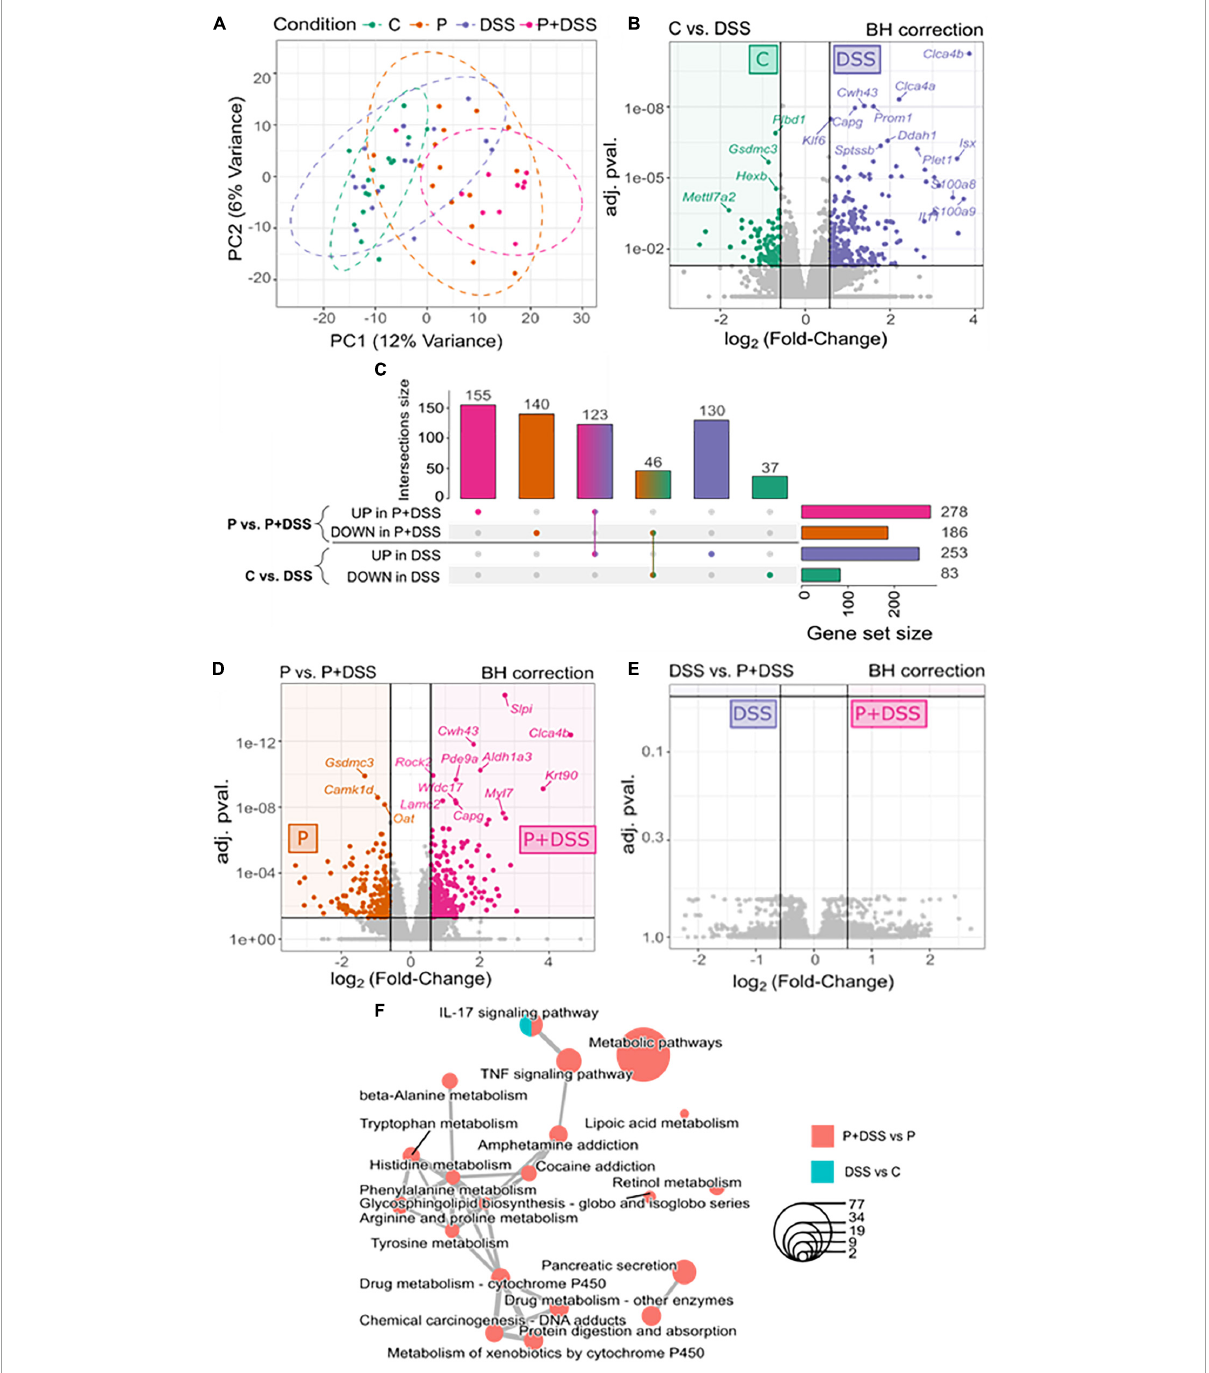
FIGURE3 Prebiotic administration to mothers modulates the transcriptomic response to DSS treatment in distal colon: 155 upregulated genes and 140 downregulated genes are specific to the P + DSS group. (A) Principal component analysis describes the transcriptomic profile of each mouse in the distal colon. Volcano plots show the differentially expressed genes in the distal colon for comparison (B) C vs. DSS, (D) P vs. P + DSS and (E) DSS vs. P + DSS. Upregulated genes are coloured according to the group of mice ( C , green; P, orange; DSS, violet; P + DSS, pink). Grey dots show the non-significant differences in gene expression. (C) Impact of the maternal prebiotic supplementation on the response to DSS treatment, represented by the comparisons of genes for P vs. P + DSS and C vs. DSS groups, were compared, and specific and common sets of up- and downregulated genes were identified. These identified genes were comprised in a (F) network of enriched pathways from the Kyoto Encyclopedia of Genes and Genomes (KEGG) pathway enrichment analysis. N = 13–19 mice/group at the beginning of the